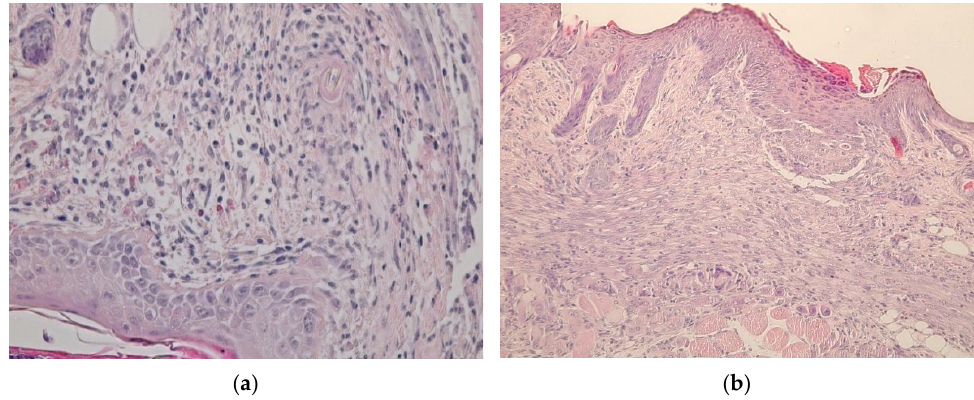
Figure 15. Results of histological studies on the 5th day of the experiment: ( a ) Control group. Stained with hematoxylin and eosin. Magnification ×400; ( b ) Experimental group. Stained with hematoxylin and eosin. Magnification ×200.